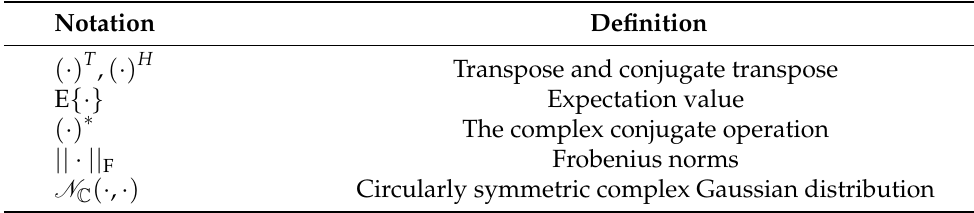
Table 1. Notations and